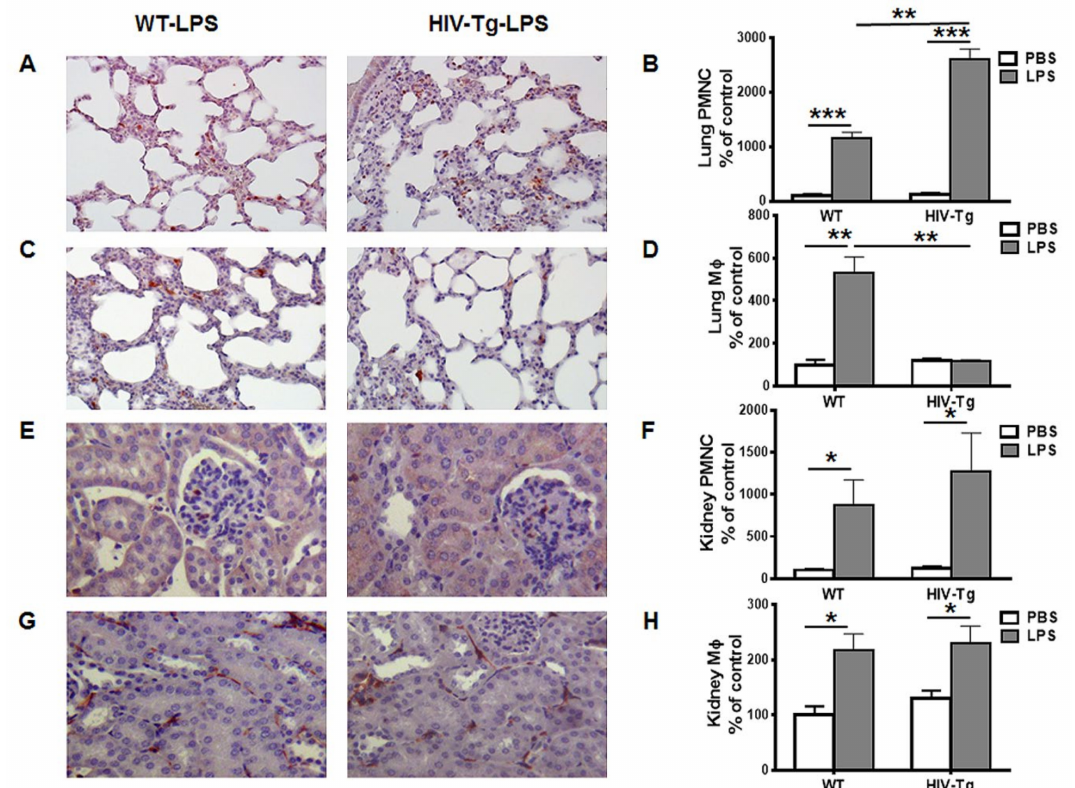
Figure 1. Infiltration of neutrophils is increased, and macrophages is decreased, in the lung but not the kidney of HIV-Tg mice 24 h after LPS injection. ( A , C ) Representative pictures of lung neutrophils ( A ) and macrophages ( C ) immunostaining (red color). Original magnification is 200X. ( E , G ) Representative pictures of kidney neutrophils ( E ) and macrophages ( G ) immunostaining (red color). Hematoxylin is used for counterstaining (purple nuclear staining). Original magnification is 400X. ( B , F ) Quantification of neutrophils (PMNC) in the lung ( B ) and the kidney ( F ). ( D , H ) Quantification of macrophages (M φ